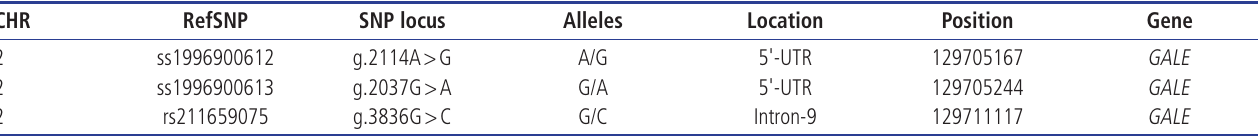
Table 1. Information for the three identified single nucleotide polymorphisms in UDP-galactose-4-epimerase gene CHR RefSNP SNP locus Alleles